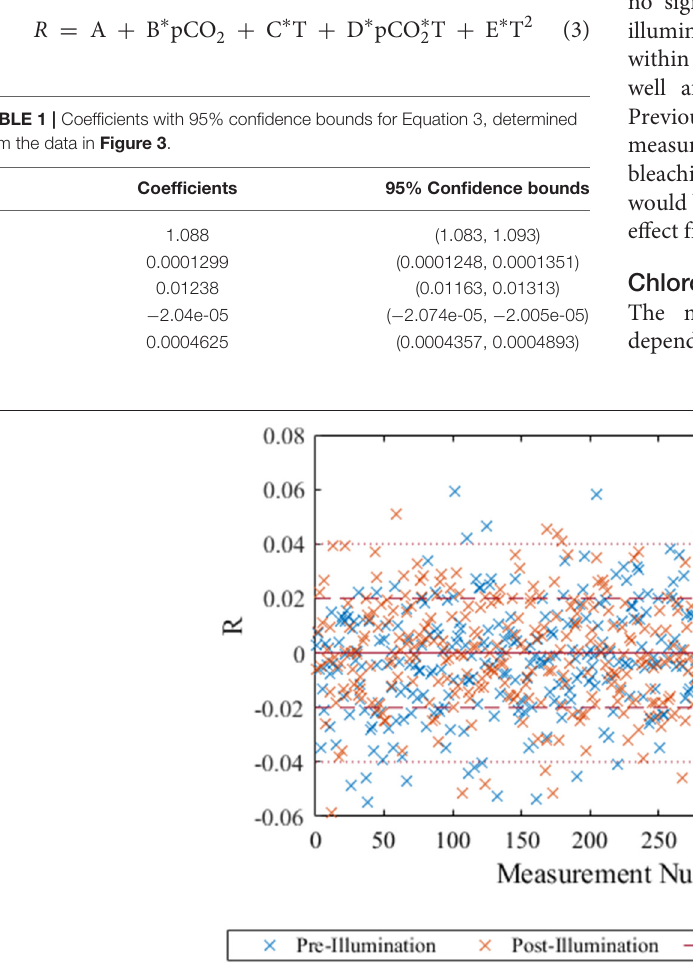
Frontiers in Marine Science |